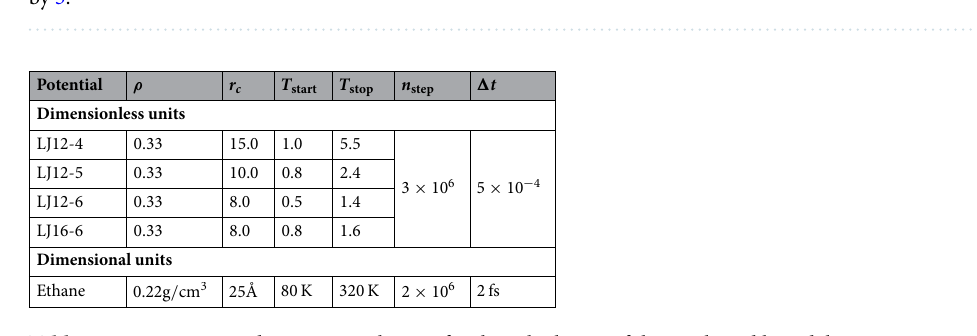
Table 3. Parameters used in MD simulations for the calculation of the gas-liquid